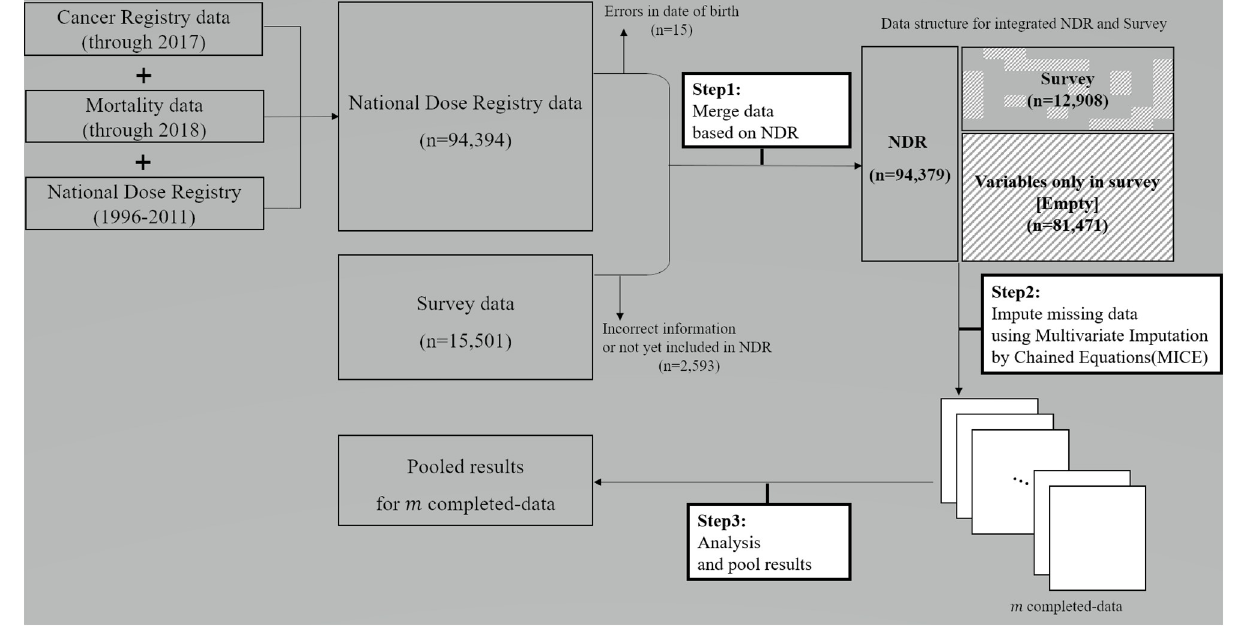
Fig 1. Overview of the data integration process.